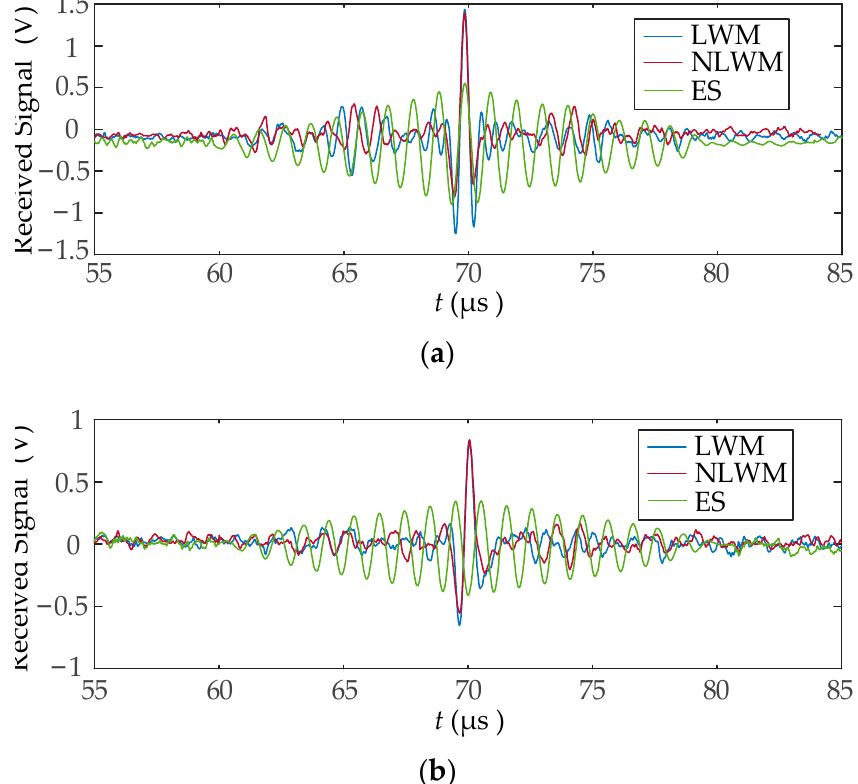
Figure 14. The received signals after enlargement: ( a ) case 1; ( b ) case 2. Table 1. MLW and SNR in the experiment.